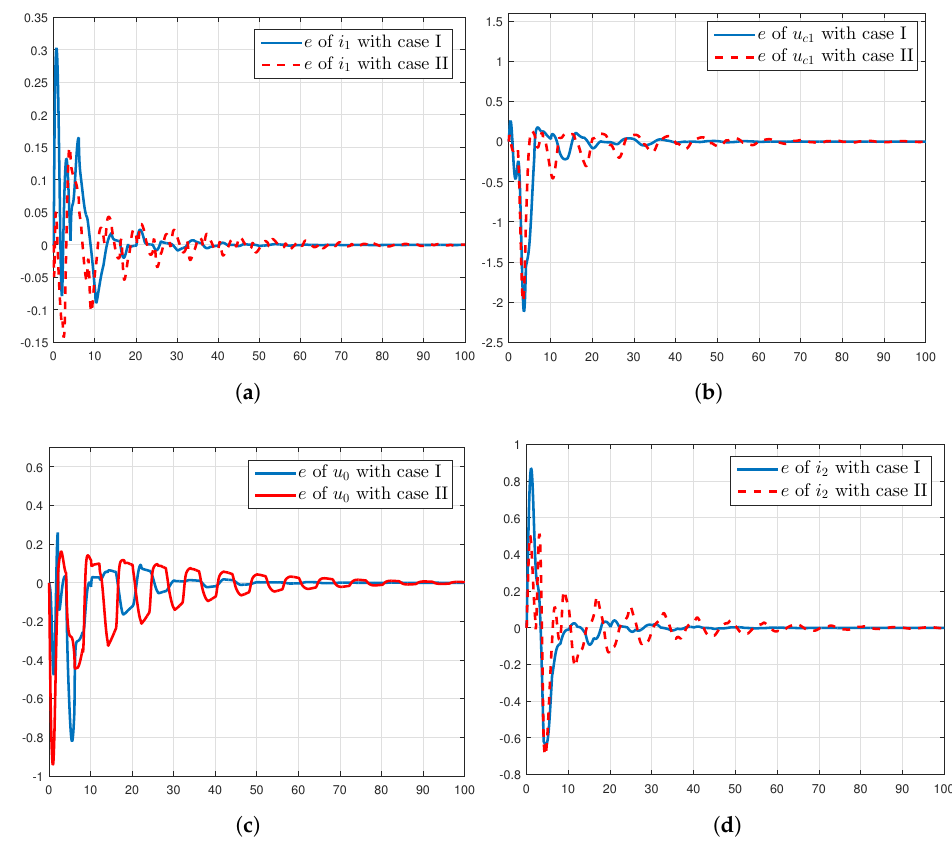
Figure 9. Estimation errors with case I and II. ( a ) Estimation error of i 1 . ( b ) Estimation error of u c 1 . ( c ) Estimation error of u 0 . ( d ) Estimation error of i 2 .